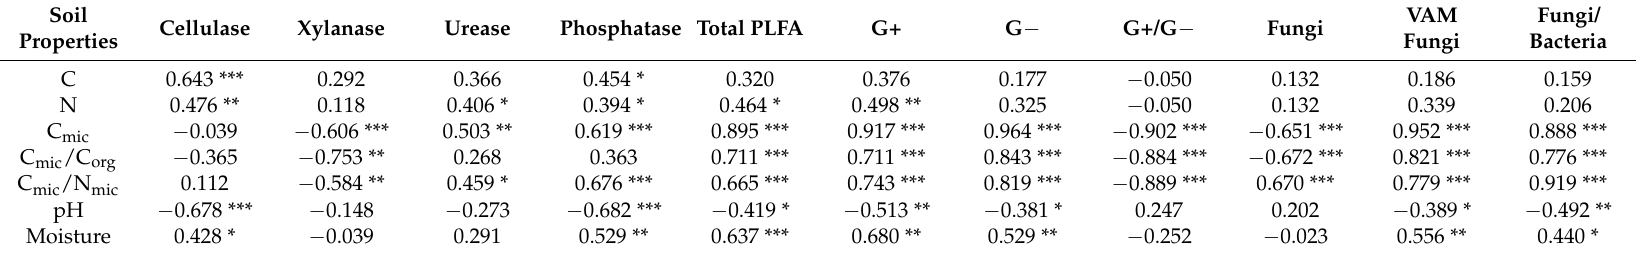
Table 5. Pearson’s correlation coefficients between soil properties and microbial